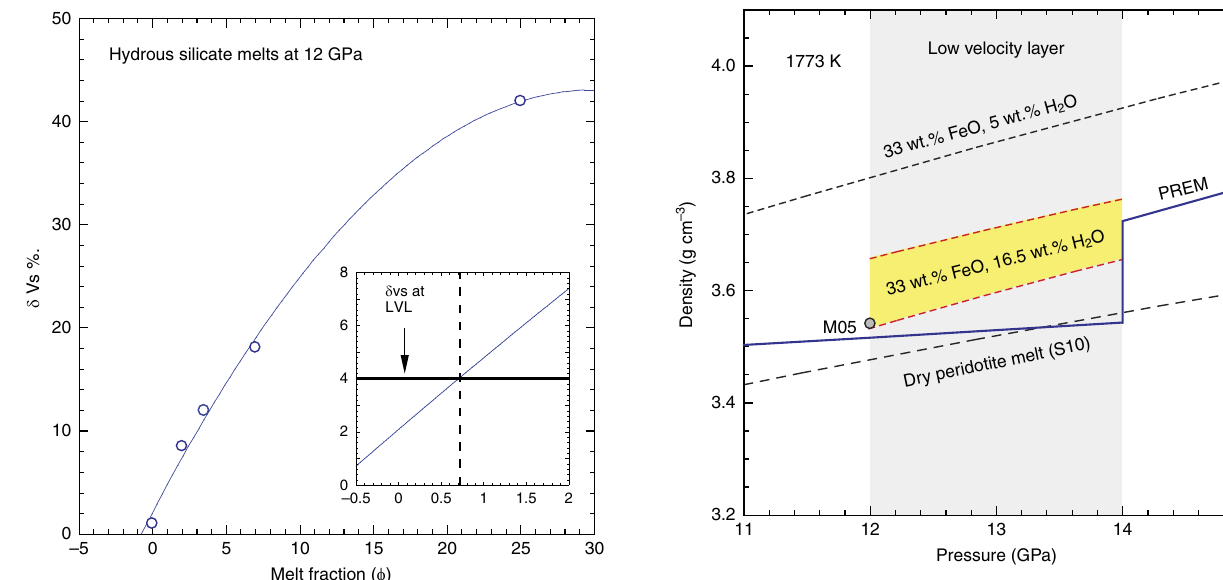
Fig. 4 The % drop in secondary wave velocity as a function of sample melt fraction. The second order polynomial fi tting indicates the best fi tting line up to 25% melt fraction. The inset fi gure indicates the melt fraction required to explain the geophysically observed − 4% δ Vs, yielding 0.7% of melt fraction for the LVL above the mantle transition zone